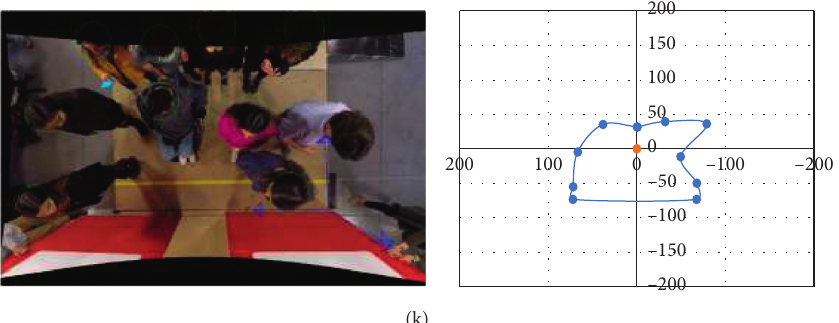
Figure 9: Graphical representation of space (measured in cm) occupied by a wheelchair user in the case of 1.50 passengers/m 2 (11 runs).